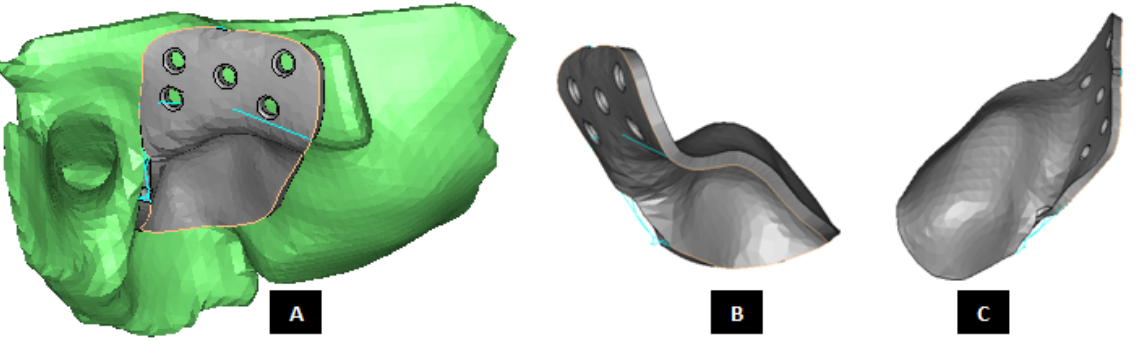
Figure 13. A simple custom-design of the fossa prosthesis with screw holes. ( A ) Demonstrates that the implant is designed for optimal usage of natural fossa eminence for fixation using screws. ( B , C ) Show different views of the implant illustrating the custom shape accurately conforms to the contours of host anatomy. The implant has constant thickness throughout its body, and the shape of articulating surface is same as that of the natural articular surface.